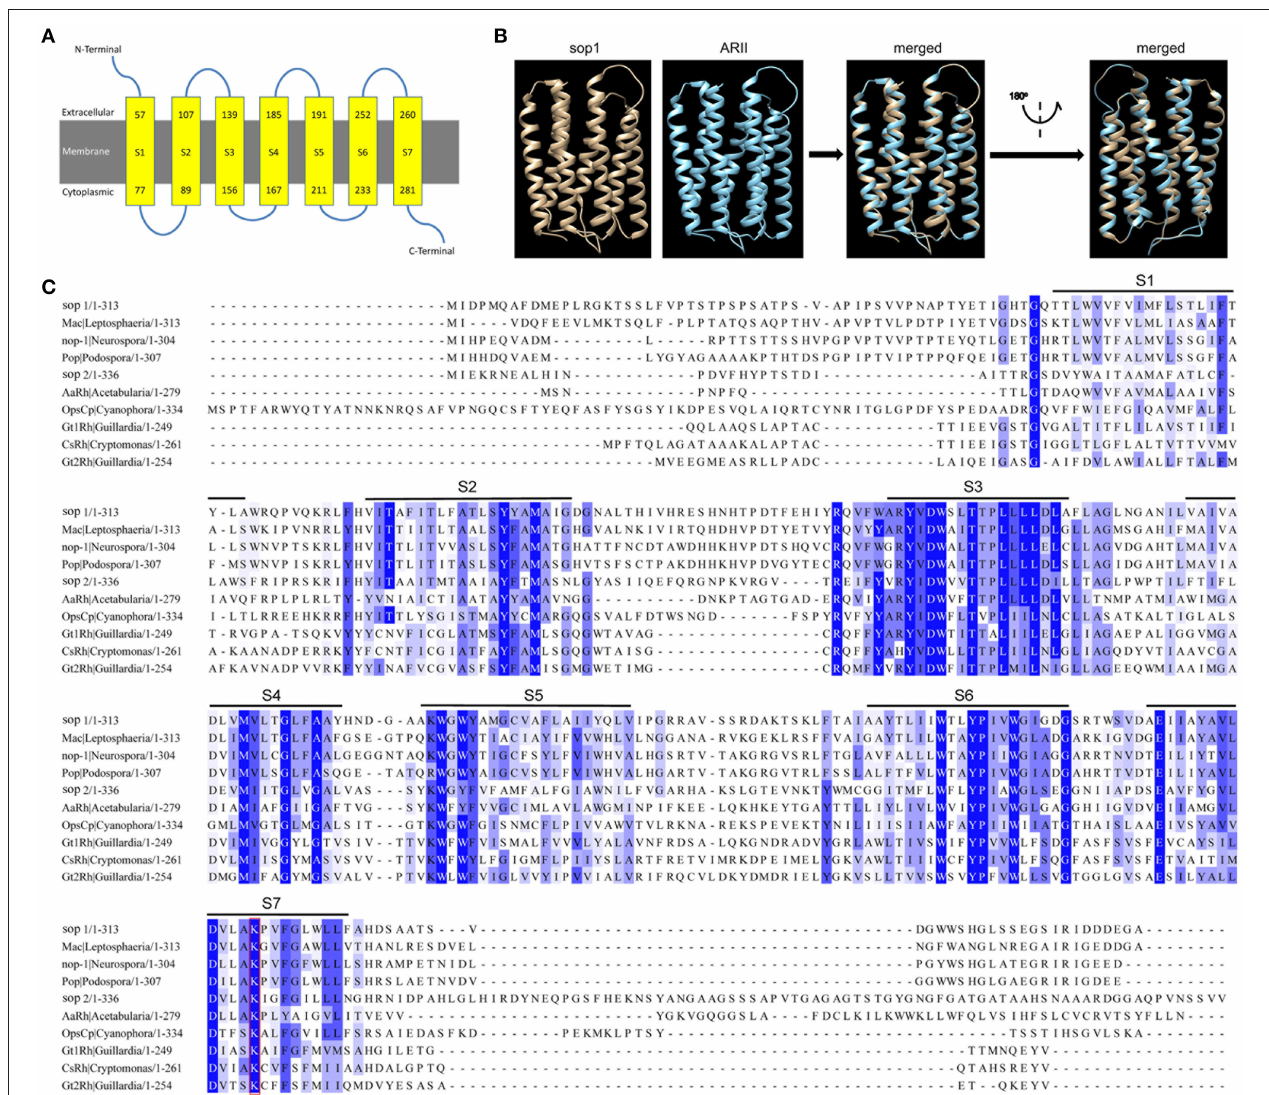
FIGURE 1 | Characterization of sop1 in S. sclerotiorum . (A) A schematic diagram of seven transmembrane structures (S1–S7, yellow boxes) that were predicted with the Phyre2 program. Numbers in the yellow boxes indicate start and end sites of each transmembrane helix of sop1, respectively. (B) Comparison of 3D structural models of sop1 (from 50 aa to 287 aa) and eukaryotic light-driven proton pumping rhodopsin, Acetabularia rhodopsin II (arII), from marine alga A. acetabulum (Wada et al., 2011). The 3D structural models were generated with the Phyre2 program. 218 residues (70% of sop1) have been modeled with 100% confidence by the single highest scoring template c3am6C in the Phyre 2 database. (C) Multiple alignment of the protein sequences of sop1, sop2, Mac in L. maculans (GenBank accession: AAG01180), nop-1 in N. crassa OR74A (GenBank accession: XP_959421), Pop in P. anserine S mat+ (GenBank accession: XP_001904282), AaRh in A. acetabulum (GenBank accession: AAY82897), OpsCp in C. paradoxa (GenBank accession: ACV05065), Gt1Rh in G. theta (GenBank accession: ABA08437), CsRh in Cryptomonas sp. S2 (GenBank accession: ABA08439), and Gt2Rh in G. theta (GenBank accession: ABA08438) using COBALT